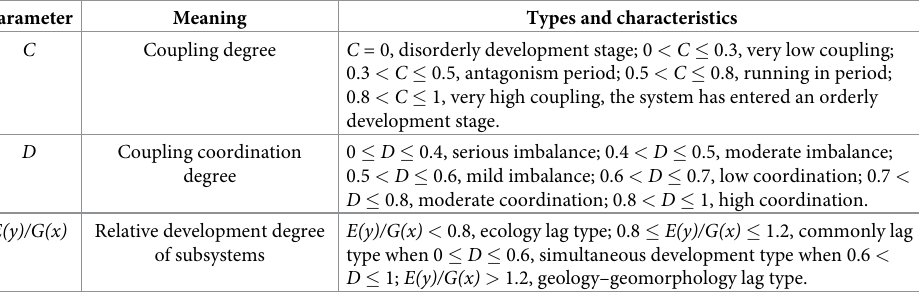
Table 2. Types and characteristics of C , D and E(y)/G(x) in the research. Parameter